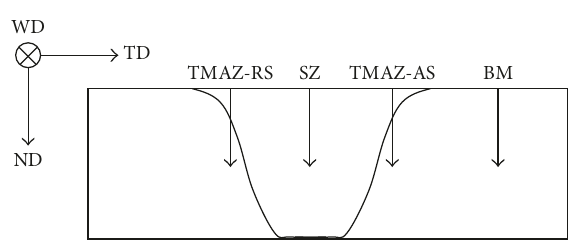
Figure 3: Schematic illustration of the residual stress measurement position.